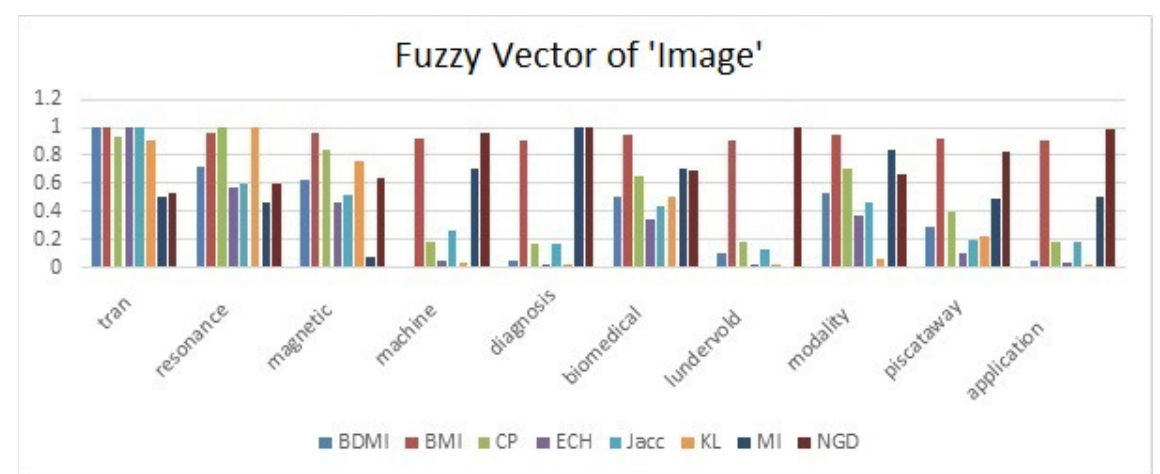
Figure 4. Fuzzy context vector extraction of term "Image" with different techniques